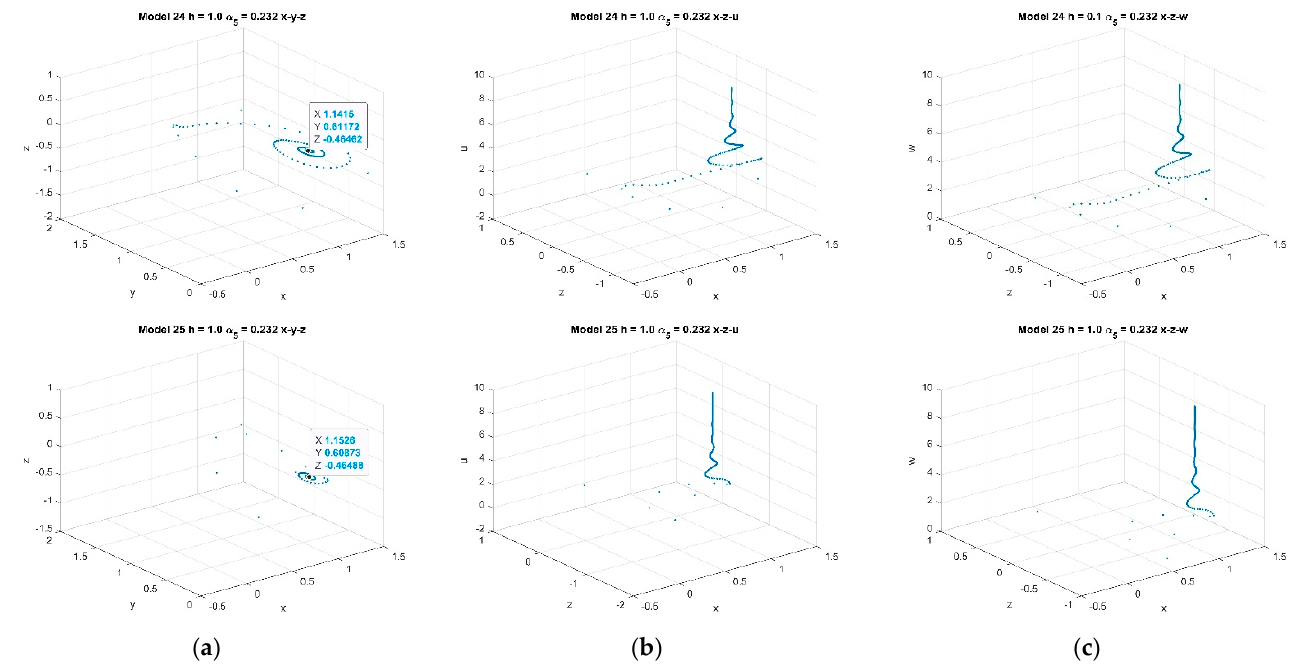
Figure 10. Phase portraits ( a ) x − y − z , ( b ) x − u − z , ( c ) x − z − w , at h = 1.0, k = 2, p = 1, α 5 = 0.232 for models (22) through (25). h = 1.0, α 5 = 0.232 for (23) through (25). 4.2.2. Varying p with Fixed k = 2, α 5 = 0.3, and p ∈ [ 1, 2 ]